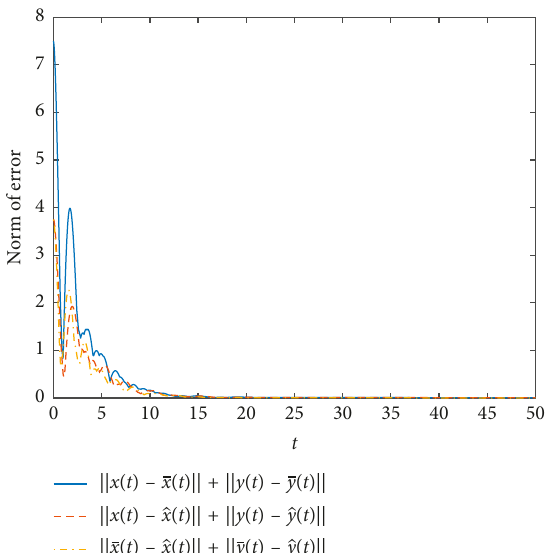
Figure 9: Time evolutions for the norms of errors in Example